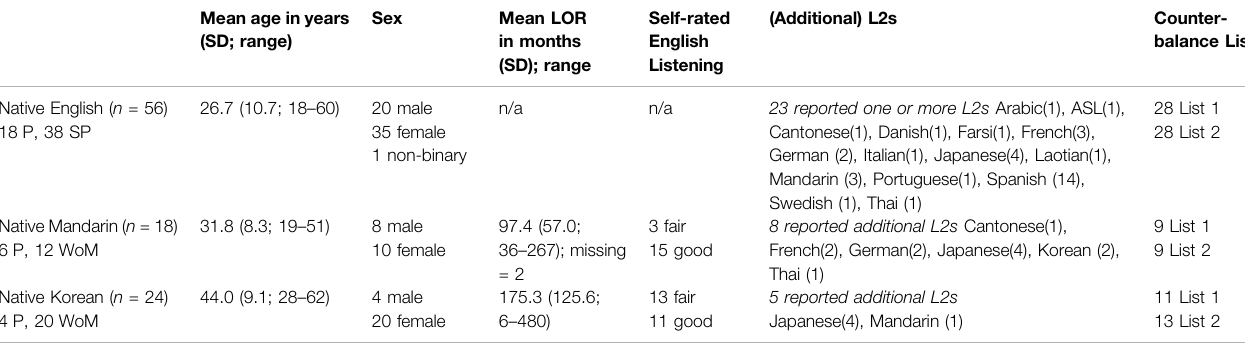
TABLE 3 | Summary of participant characteristics.